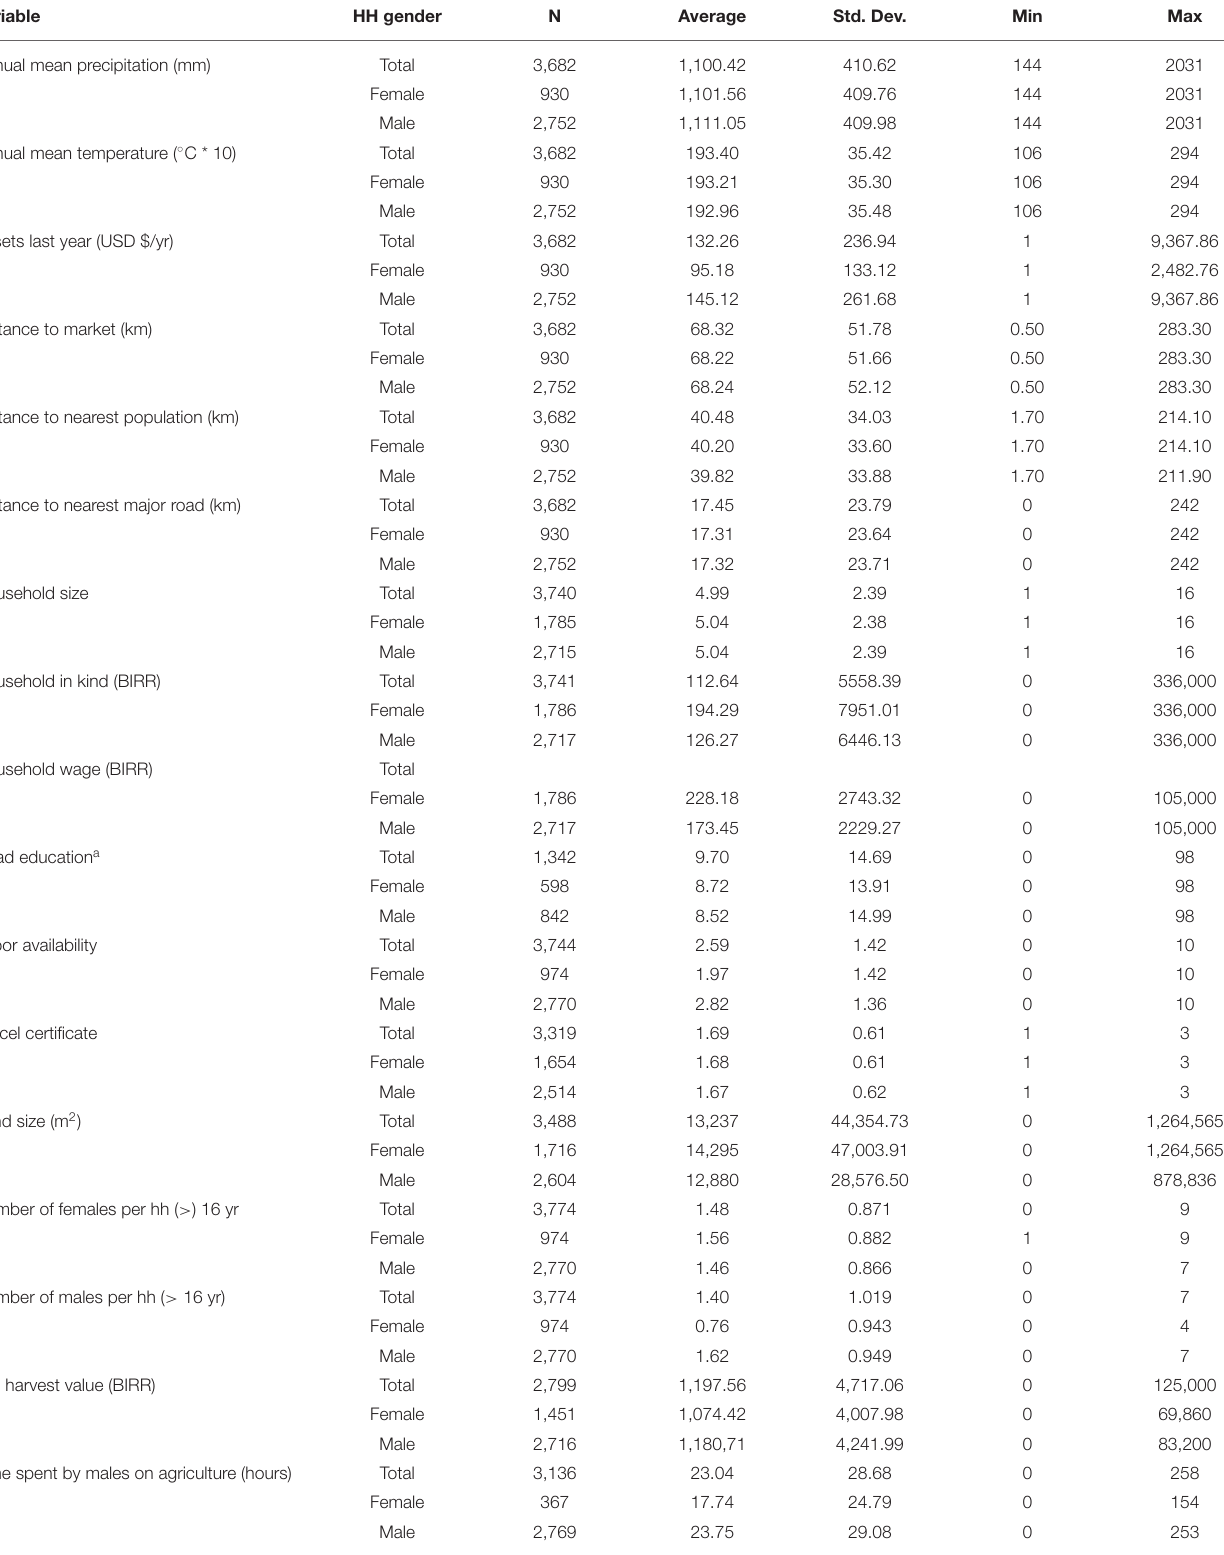
TABLE 1 | Descriptive statistics of rural households in Ethiopia (Source: CSA-LSMS-WB, 2015) ( N = 3,744).